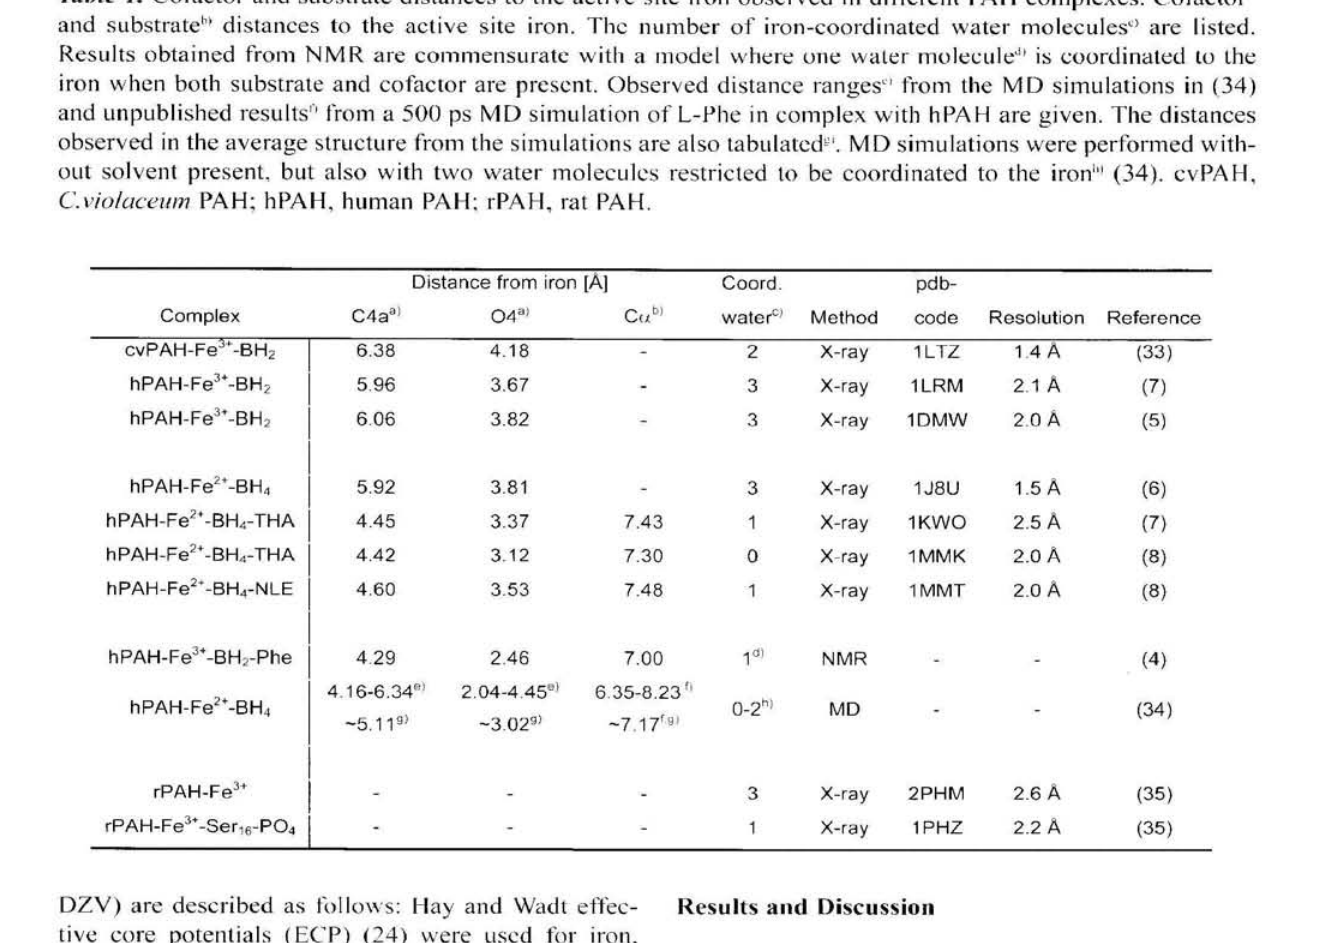
Table 1. Cofactor and substrate distances to the active site iron observed in different PAH complexes. Cofactor" and substrate' 1 ' distances to the active site iron. The number of iron-coordinated water molecules"' are listed. Results obtained from NMR are commensurate with a model where one water molecule' 1 ' is coordinated to the iron when both substrate and cofactor are present. Observed distance ranges 0 from the MD simulations in (34) and unpublished results" from a 500 ps MD simulation of L-Phe in complex with hPAH are given. The distances observed in the average structure from the simulations are also tabulated 51 . MD simulations were performed with- out solvent present, but also with two water molecules restricted to be coordinated to the iron 1 " (34). cvPAH,